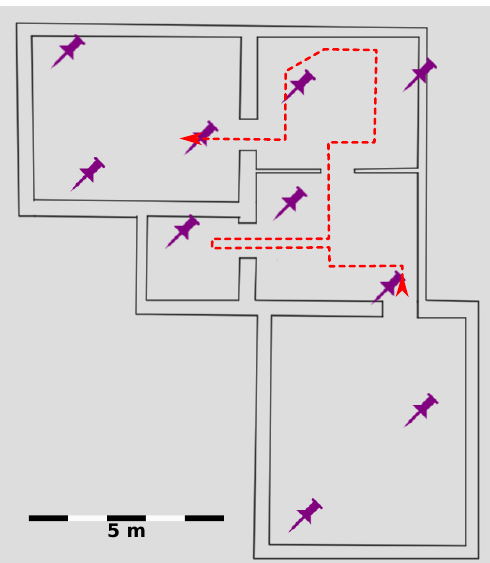
Figure 7. A schematic map of the test environment for measurements, where purple thumbtacks are